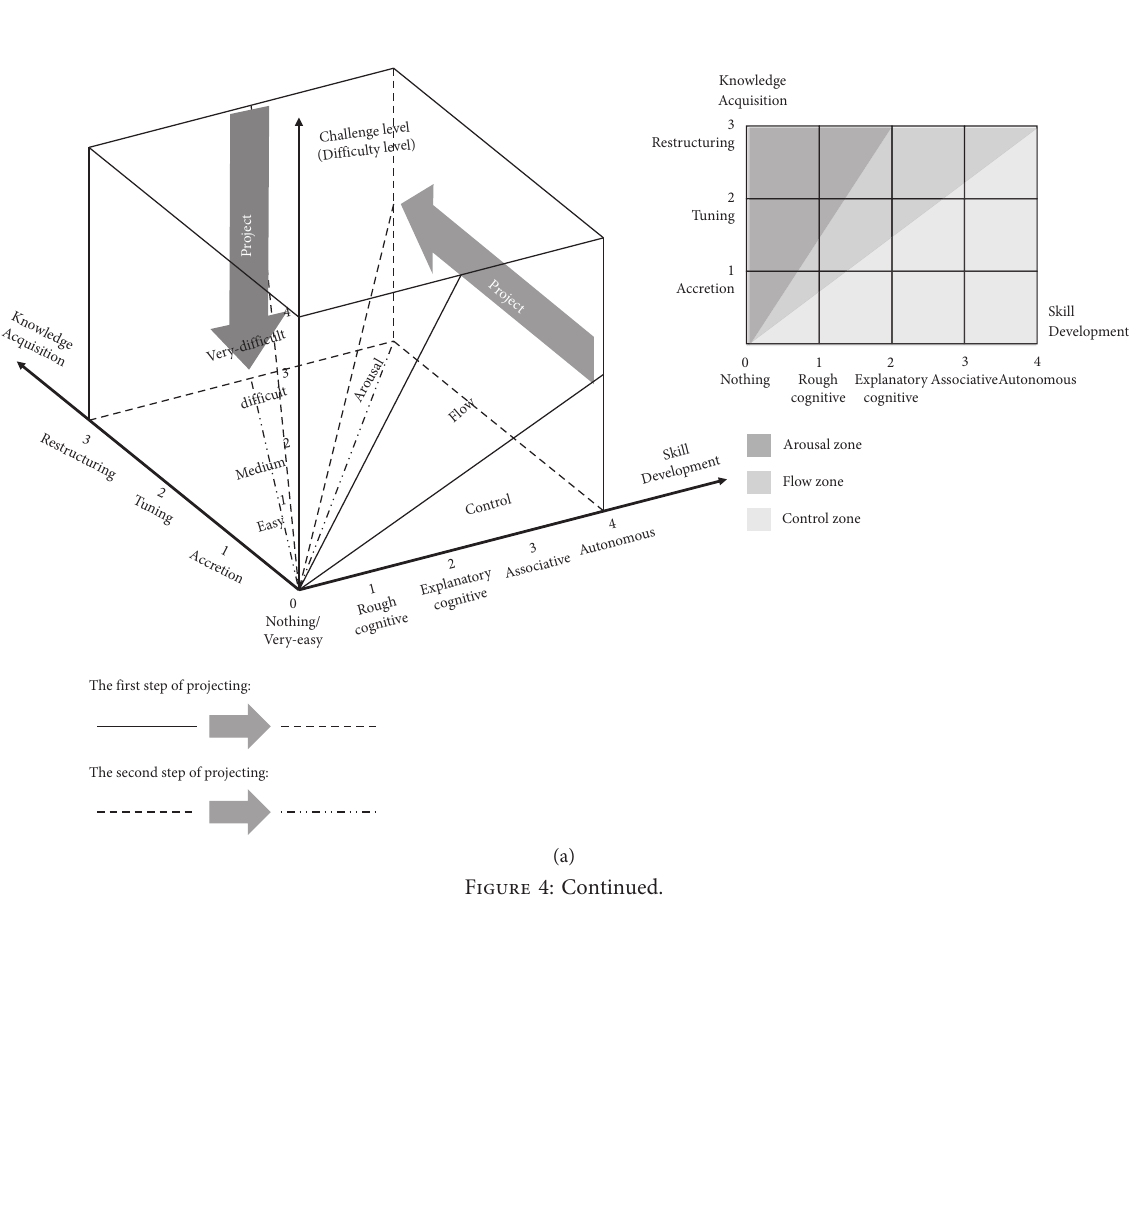
Figure 3: The Learner’s Growth Model (left) [73, 74] and the rectangular coordinate system presenting transition between stages (right).